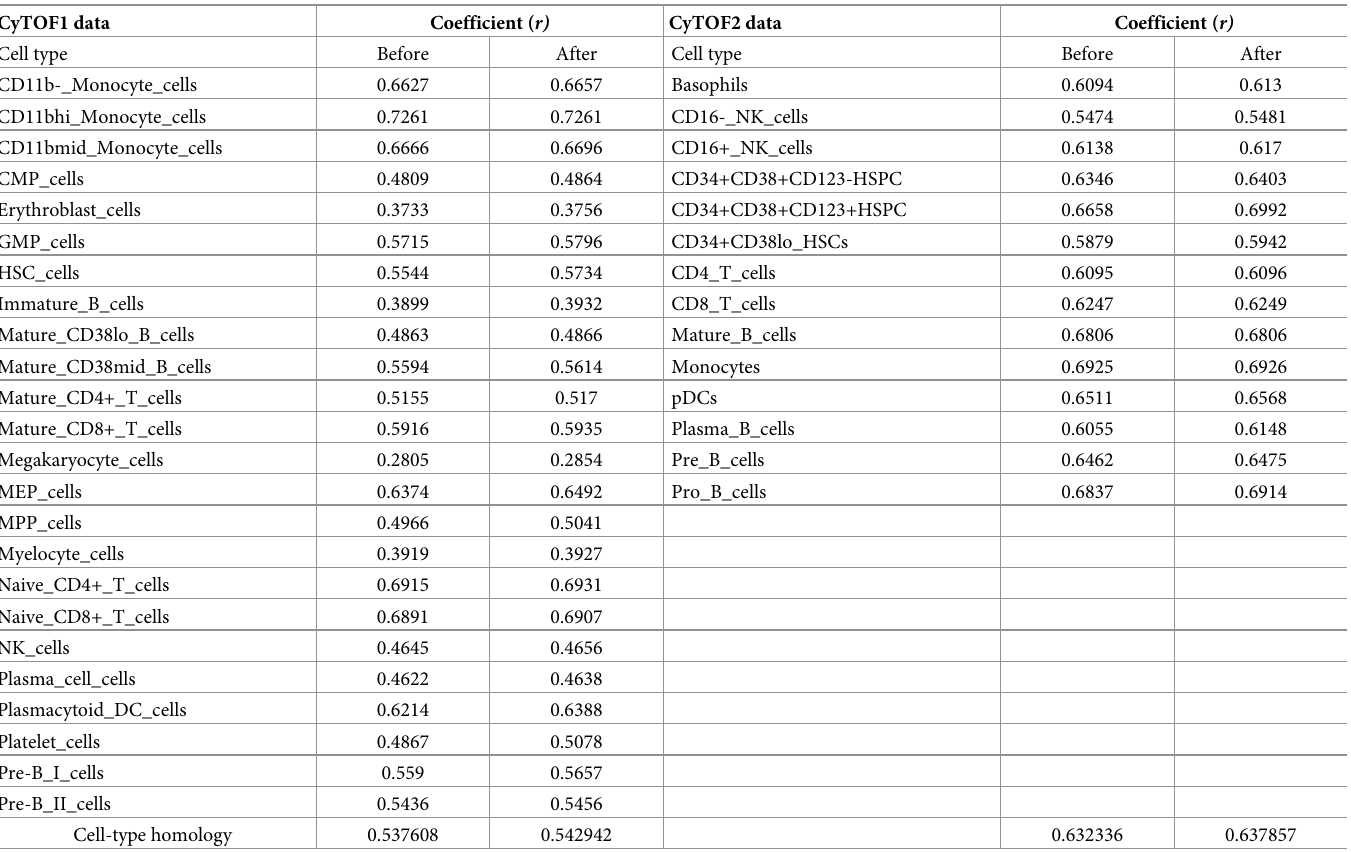
Table 6. Calibration of cell types utilizing calibration feedback for CyTOF1 and CyTOF2